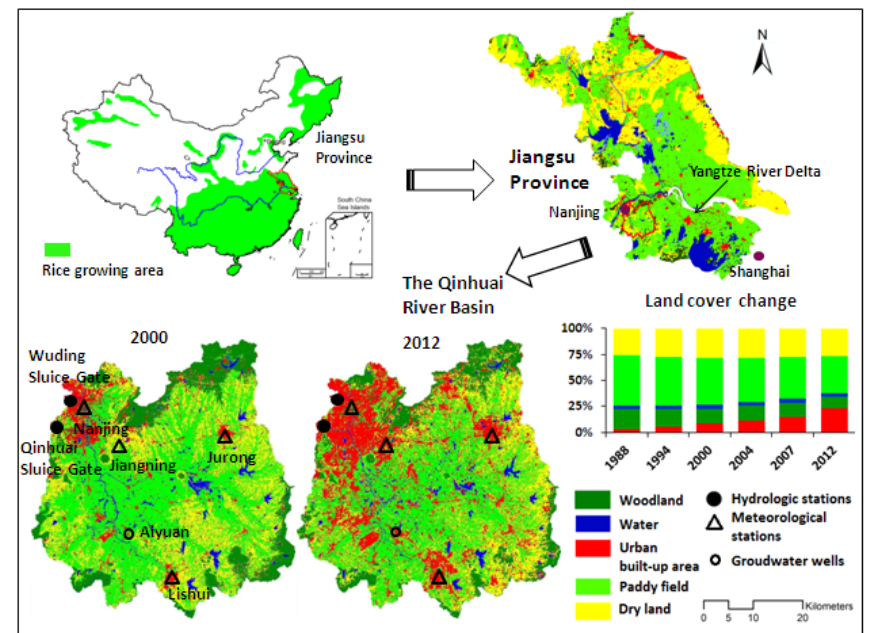
Figure 2. Watershed location, instrumentation, and land-use change patterns in the Qinhuai River basin, Yangtze River Delta in southern China. The insert map showing changes in land use derived from published data (Du et al., 2012; Chen and Du, 2014) (1988 and 1994) and Landsat 7 ETM + images (2000–2012).